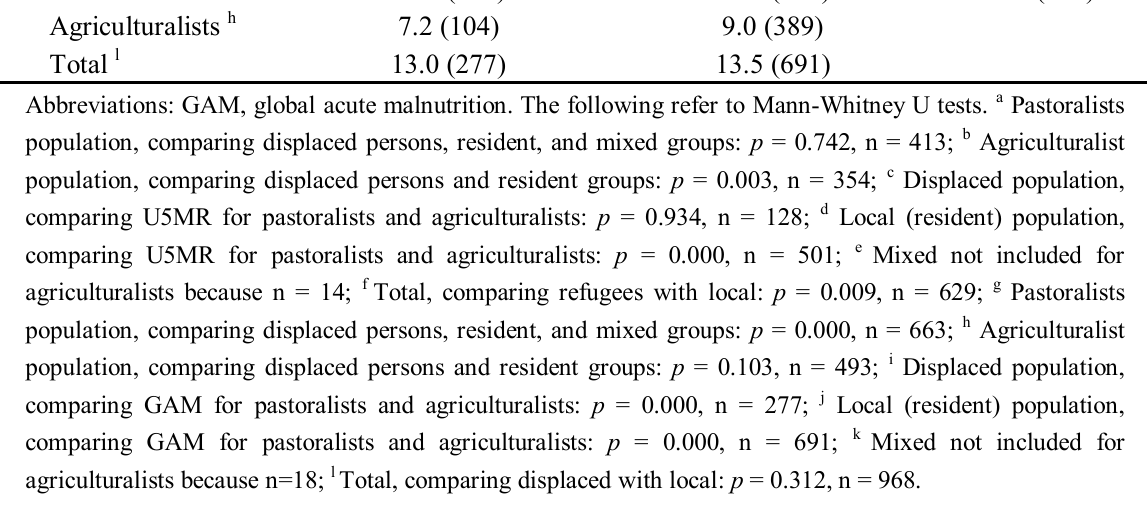
Table 2. Under-5 mortality (deaths/10,000/day) and GAM (%) by periods of years refugees/IDP, resident and mixed populations combined between 1997 and 2009 (n = number of survey results; p values estimated by Kruskall-Wallis non-parametric tests). Global Acute Malnutrition Under-5 Mortality (n) (with oedema included)